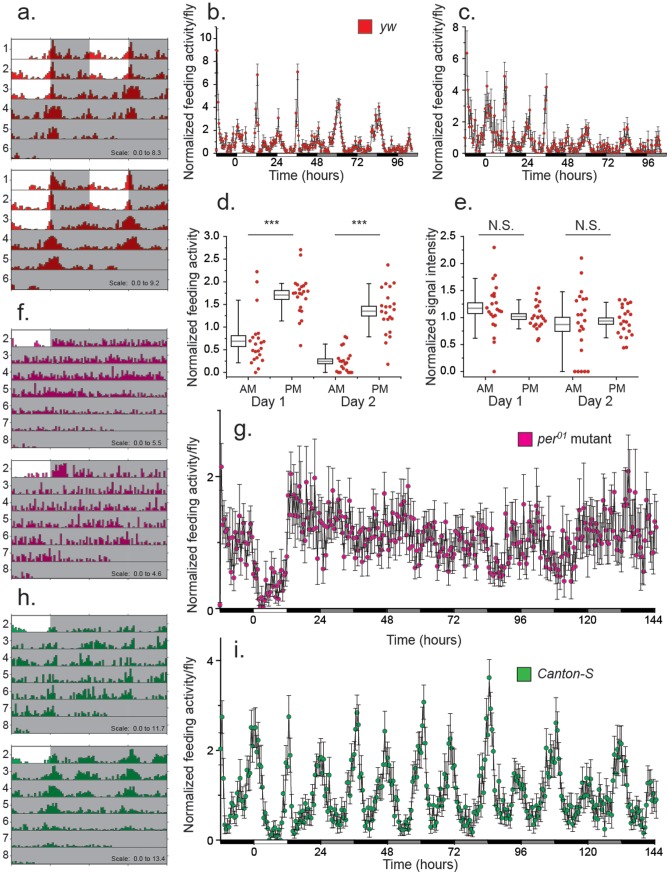
Feeding activity is circadian and dependent on the central pacemaker.(A) Representative actograms for two individual male yw flies depicting circadian feeding behavior during 12 h light: 12 h dark (LD) and constant darkness (DD) conditions. In all actograms, dark background indicates lights-off condition, and white background indicates lights-on conditions. Each horizontal line contains 48 hours of feeding activity data with the 2nd day of data on one line repeated as the first day of data on the following line to aid visualization of circadian period. (B) Averaged normalized feeding activity as a function of time reveals a strong circadian pattern of feeding behavior. Significant behavior events were determined using an adaptive threshold (N = 22). (C) Strong circadian patterns of feeding activity persist when a conservative criterion for behavior detection is used (N = 22). (D) Total feeding activity is higher in the subjective evening compared with subjective morning. Normalized feeding activity of each fly was obtained from the 2 hour window centered on the subjective lights-on and lights-off times during the first and second days of complete darkness (two-tailed paired-sample t-test; ***P≤0.0001). (E) The frequency distributions of feeding intensity signals are not different between morning and evening times. Normalized signal intensity of feeding events for each fly were from the 2 hour window centered on the subjective lights-on and lights-off times during the first and second days of complete darkness (two-tailed paired-sample t-test; P>0.05). (F). Representative actograms of feeding patterns from two individual male Per01 mutant flies. (G) Averaged normalized feeding activity as a function of time for male Per01 mutant flies provides no evidence for feeding rhythms (N = 17). (H) Representative actograms of feeding patterns from two individual male Canton-S control flies. (I) Averaged normalized feeding activity as a function of time reveals consistent circadian rhythms for male Canton-S control flies (N = 22).